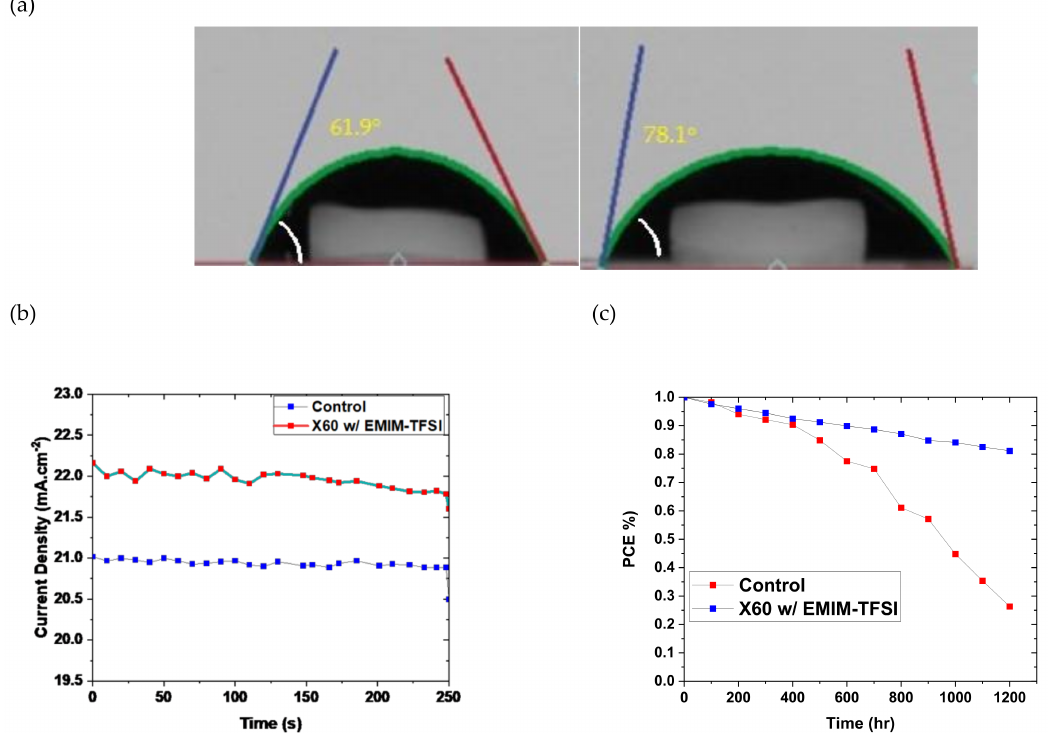
Figure 6. ( a ) Water contact angle measurements of X60:Li-TFSI (left) and X60:EMIM-TFSI (right). ( b ) Current density measured for 250 s at constant voltage close to the maximum power point (MPP) of the best performing devices. ( c ) Stability measurements of the unencapsulated devices according to the ISOS-D1 protocol (stored in the dark under humidity conditions of approximately 50–60%